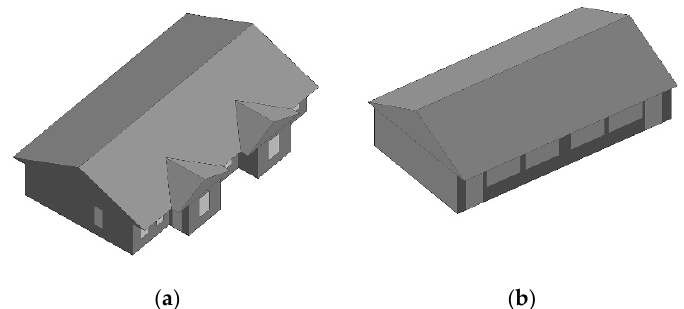
Figure 21. Building simulation model; ( a ) demonstration house; ( b ) comparative house.